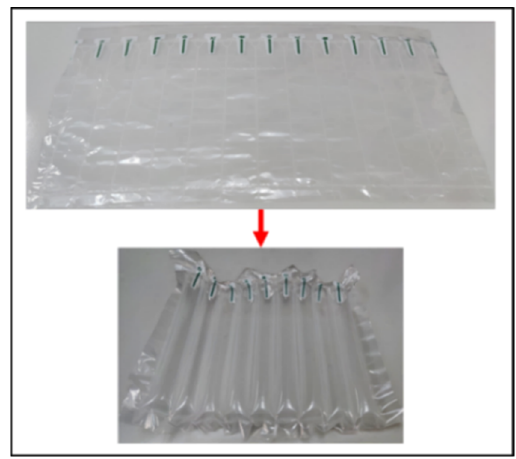
Figure 2. Flexible leg material.